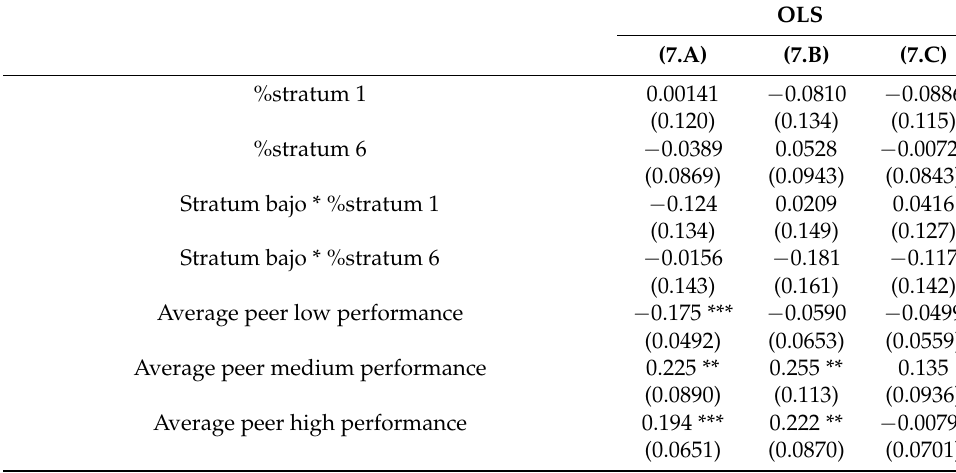
Table A3. Effects of heterogeneous peers according to the student’s academic performance in Calculus